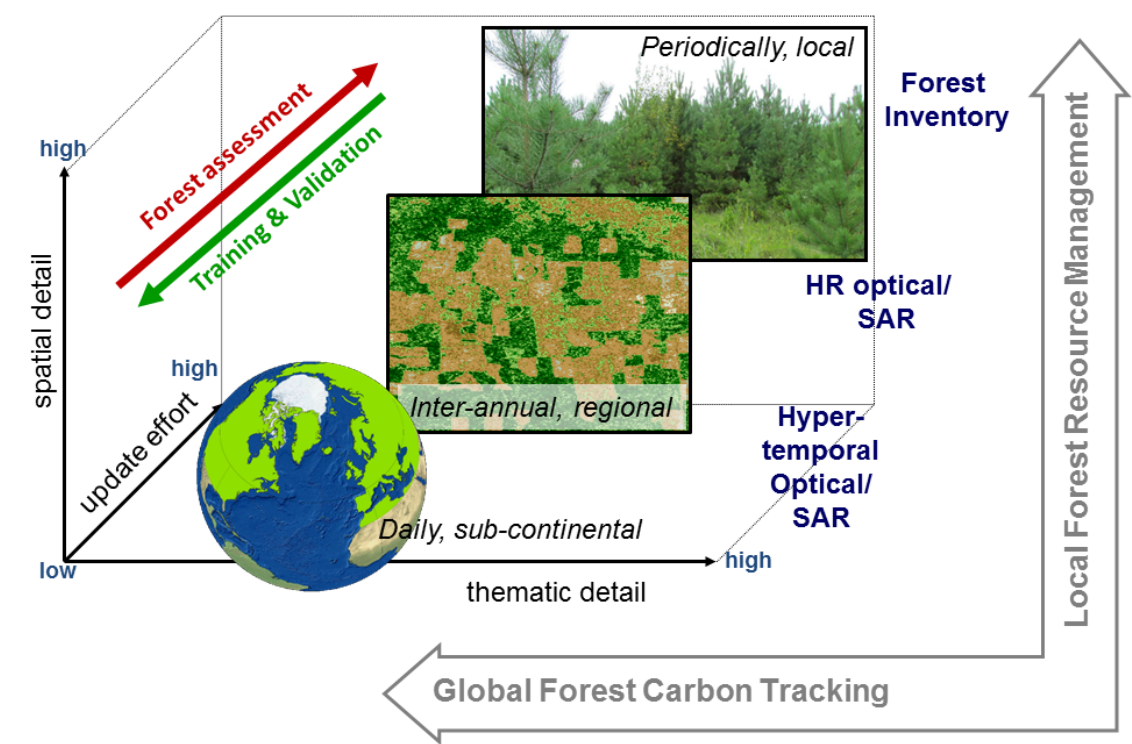
Figure 1. Integrated concept for forest resource assessment and forest geo-information cross validation; the graph exemplarily indicates the range of data specifications in terms of spatial and thematic detail in relation to the effort of frequent